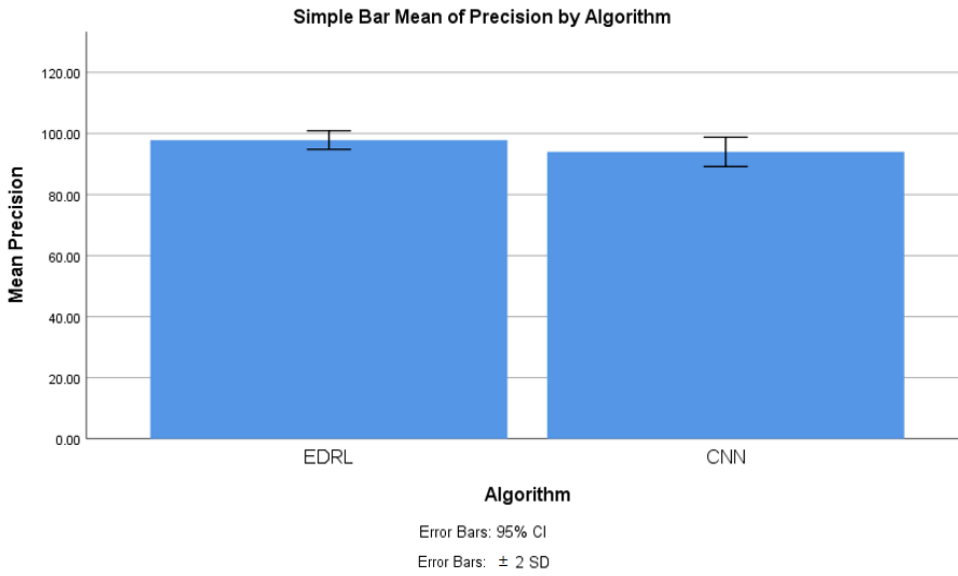
Figure 4. Precision comparison of EDRL and CNN algorithms with the error mean